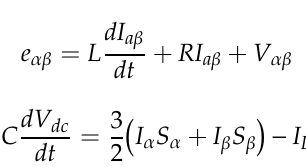
Figure 1. ( a ) AC/DC three-phase converter topology. ( b ) Voltage space vectors. Figure 1. ( a ) AC / DC three-phase converter topology. ( b ) Voltage space vectors.